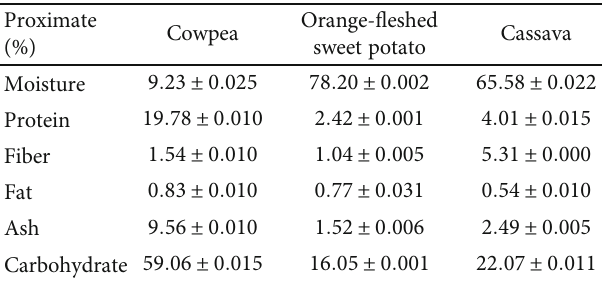
Table 1: Proximate composition of the raw materials used for the food